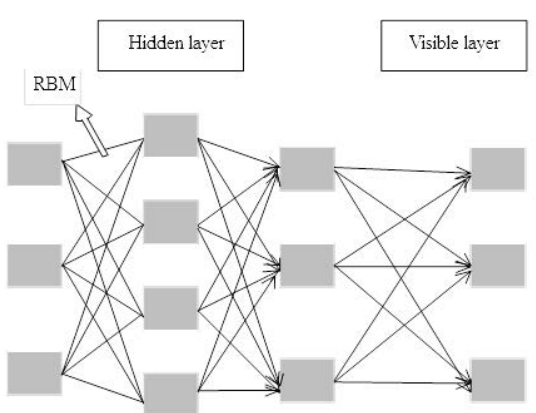
Fig. 2 DBN network. DBN: deep belief network; RBM: restricted Boltzmann machine